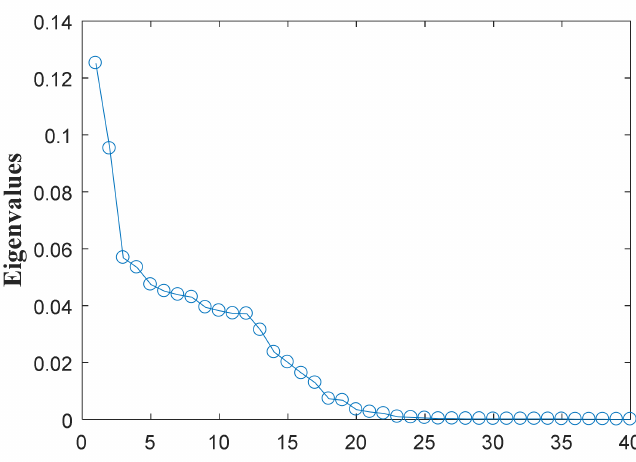
Figure 19. Eigenvalues obtained by